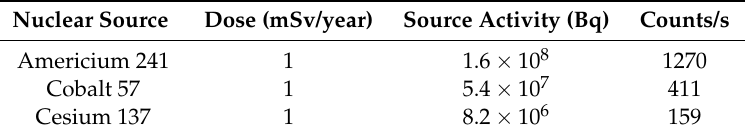
Table 1. Measured radioactivity from different nuclear sources by a 20 × 20 × 6 mm detector at a 2-m